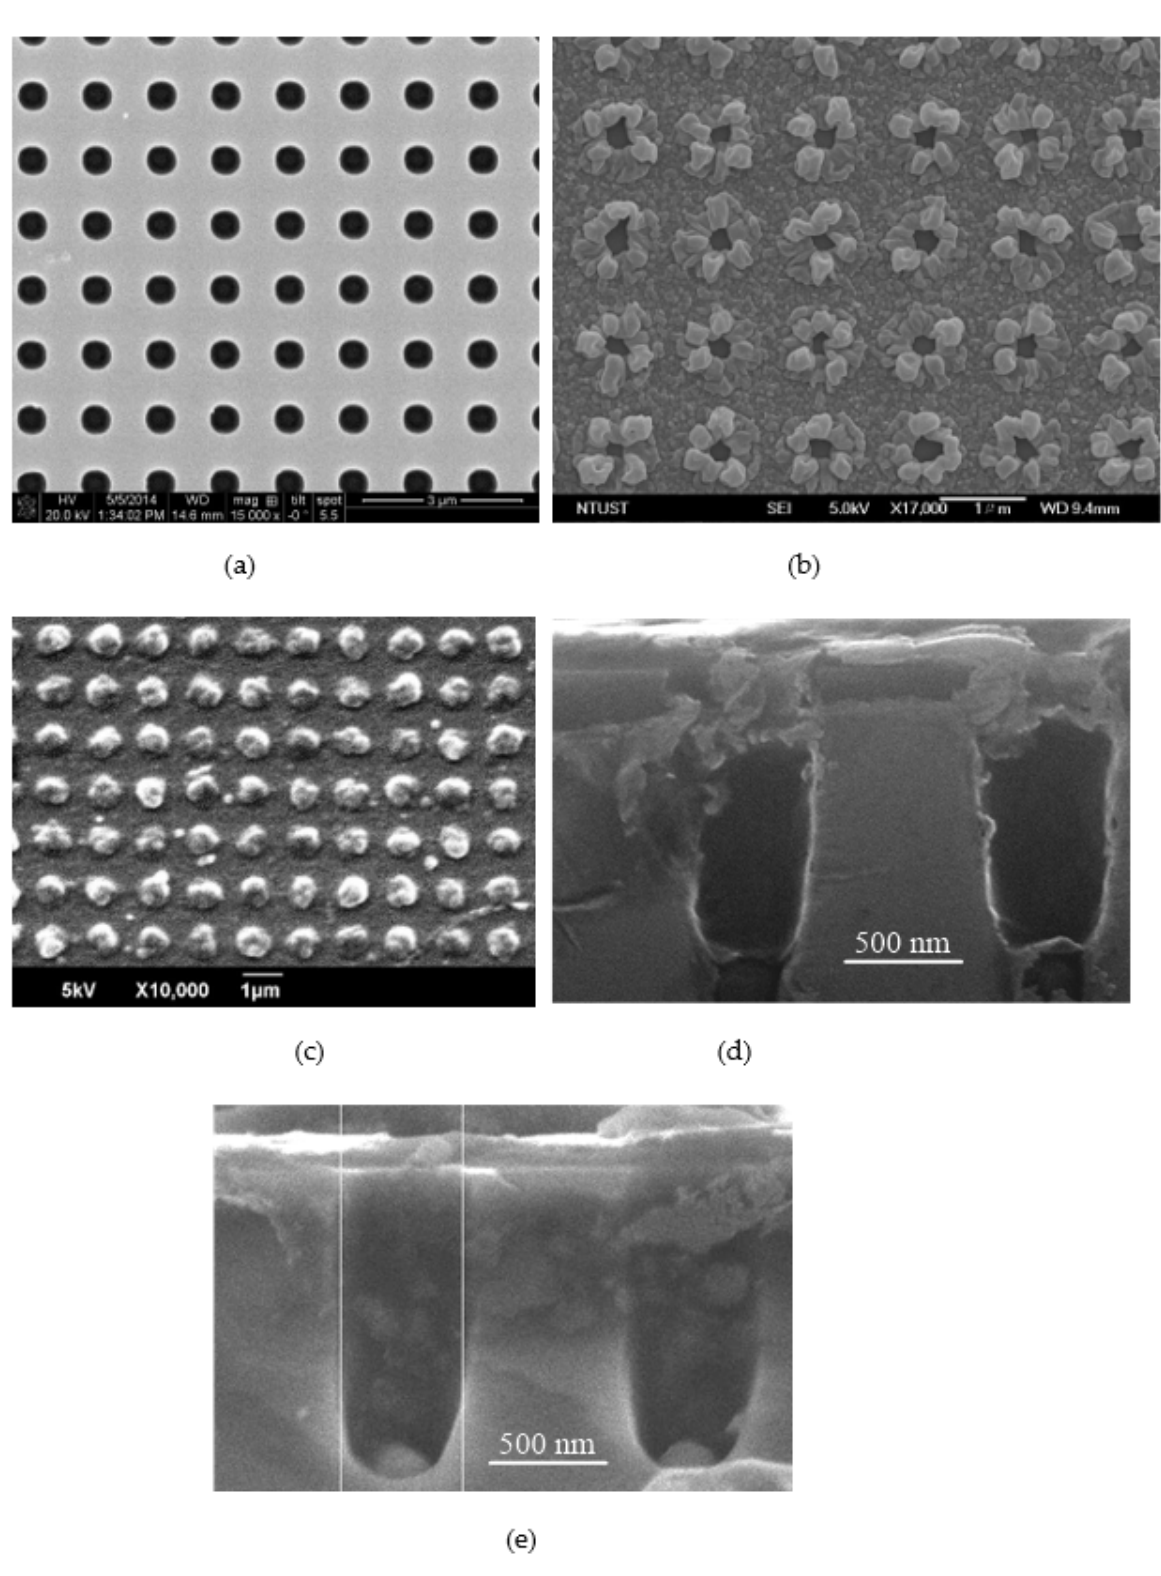
Figure 1. Top-view FESEM of ( a ) bare hole array, ( b ) 500H-P(MAA-DB), and ( c ) 500H-P(MAA-DB)- BDA on the silicon substrate, and cross-section FESEM of 500H-P(MAA-DB)-BDA ( d ) before and ( e ) after immersion in the H 2 O 2 solution at 10 nM.